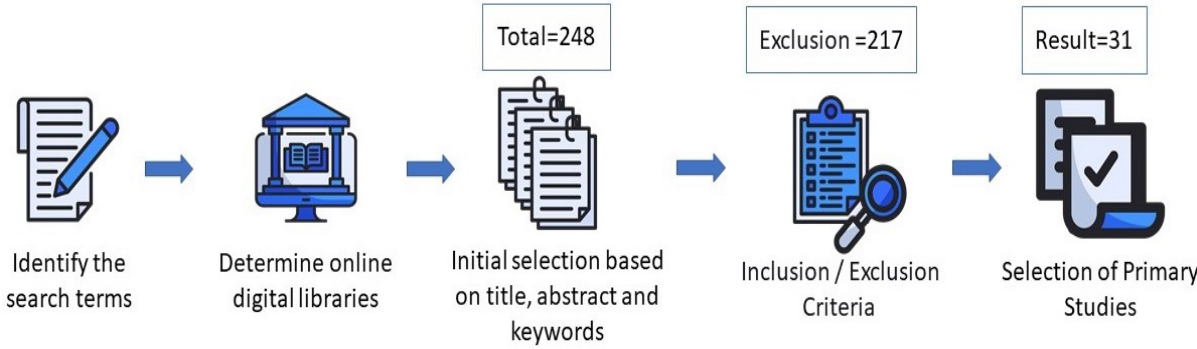
Figure 3. Primary study selection